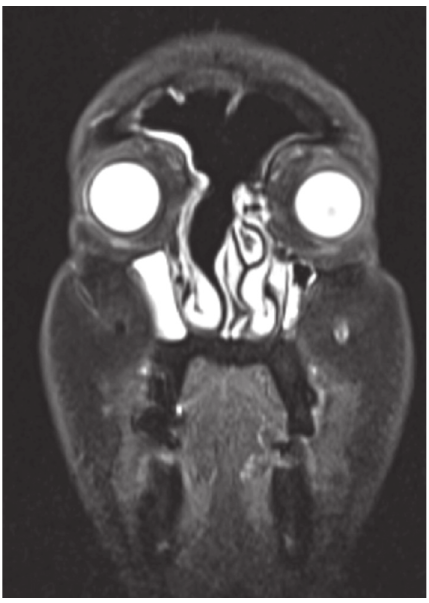
Figure 3: Post-op MRI scan (coronal plane). Postoperative MRI T1 with gadolinium enhancement after 6 months of follow-up. Total tumour clearance and no evidence of residuum/recurrence are